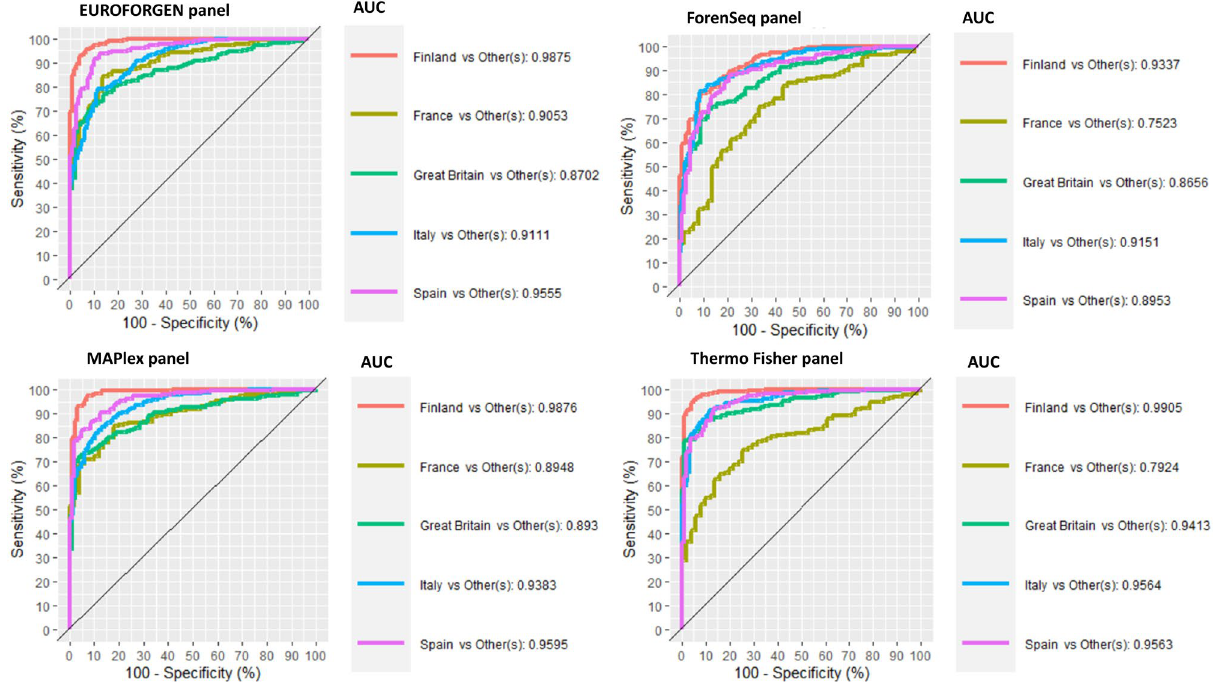
Figure 13. ROC curves, sensitivity, specificity, and AUC values for European countries and populations.